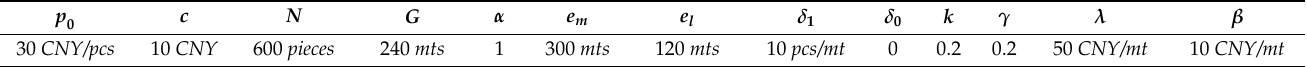
Table 3. Relevant parameter